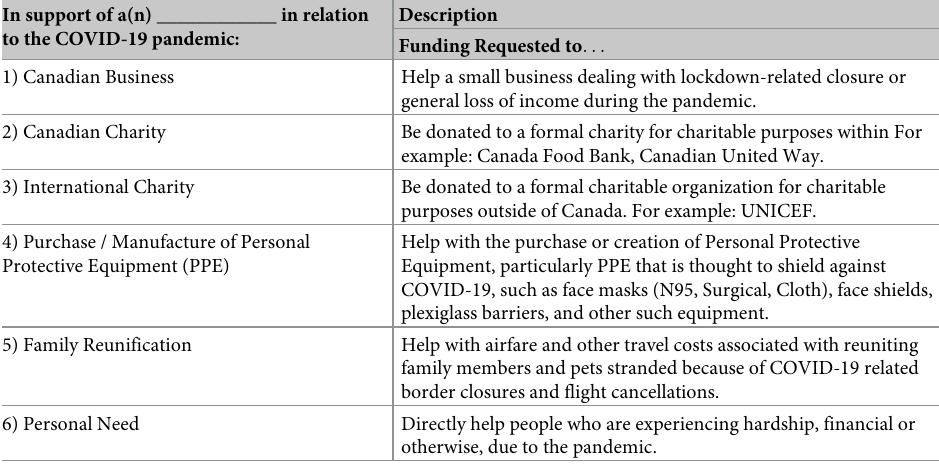
Table 1. Content categorizations used to describe the funding motivation present in the collected campaigns.